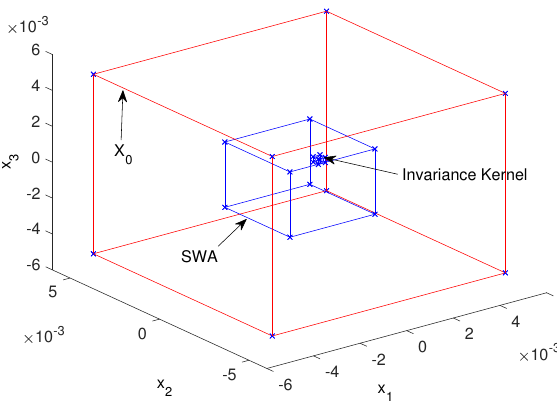
Figure 7. Initial zonotope ( X 0 ), invariance kernel and SWA for pH system.